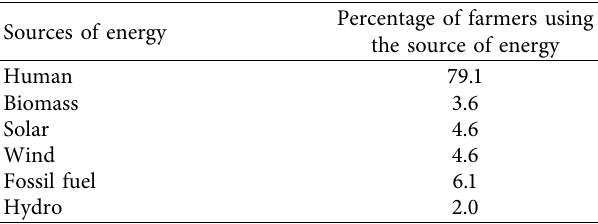
Table 3: Sources of farm energy in